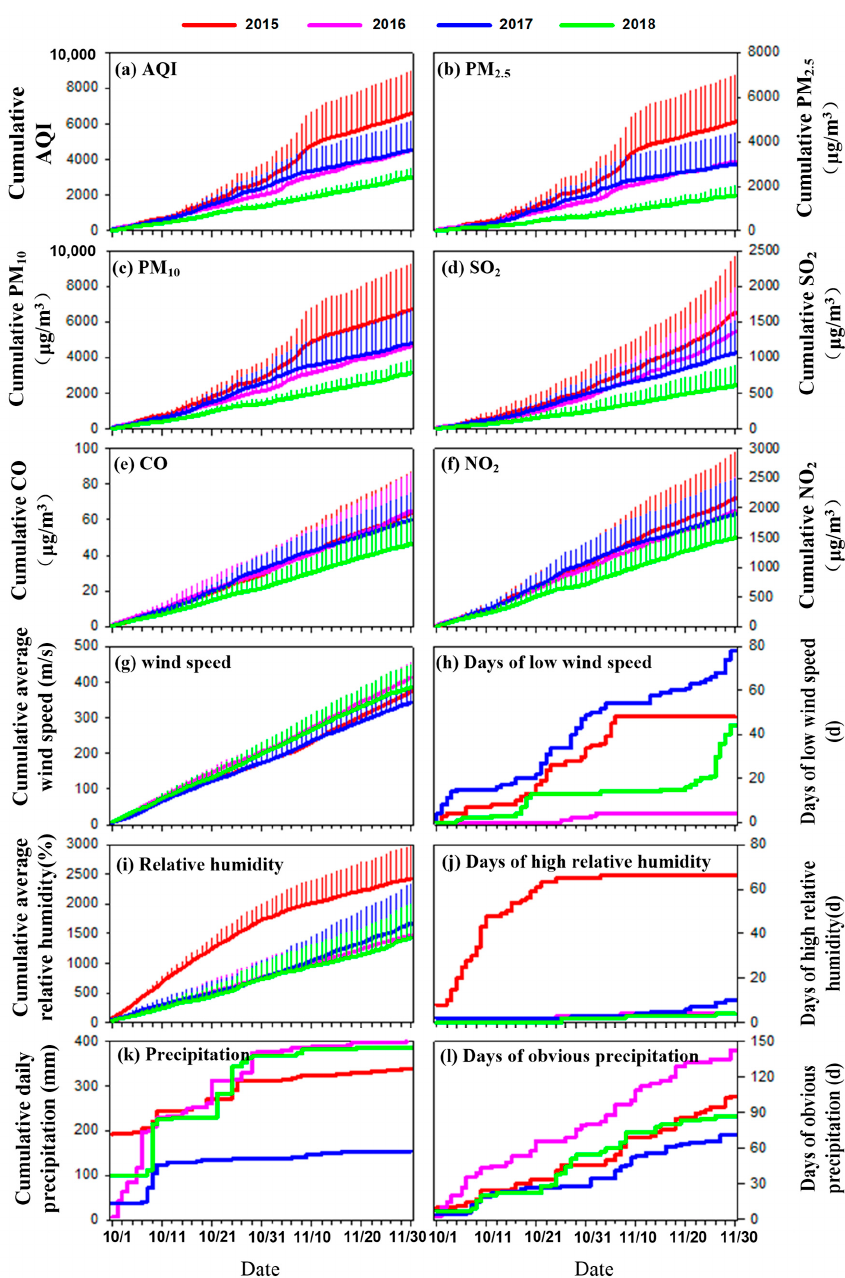
Figure 3. Air quality index and atmospheric pollutant (PM 10 , PM 2.5 , SO 2 , CO, and NO 2 ) concentrations ( a – f ), wind speed ( g and h ), relative humidity ( i and j ) and precipitation ( k and l ) during October and November from 2015 to 2018. The cumulative values of AQI, the concentration of pollutants, the average wind speed, and the average relative humidity in Jilin Province were calculated by using the daily average of the monitoring data of the nine cities and autonomous prefecture for daily accumulation. The cumulative value of daily precipitation used the sum of the nine cities and autonomous prefecture for daily accumulation. The number of low wind speed days accumulated on a daily basis using the number of days with a wind speed of less than 4m / s in the nine cities and autonomous prefecture. The accumulation of high humidity days used the number of days in which the relative humidity of the nine cities and autonomous prefecture was higher than 60% for daily accumulation. The cumulative days of obvious precipitation were accumulated daily by the days when the precipitation exceeded 5mm in the nine cities and autonomous